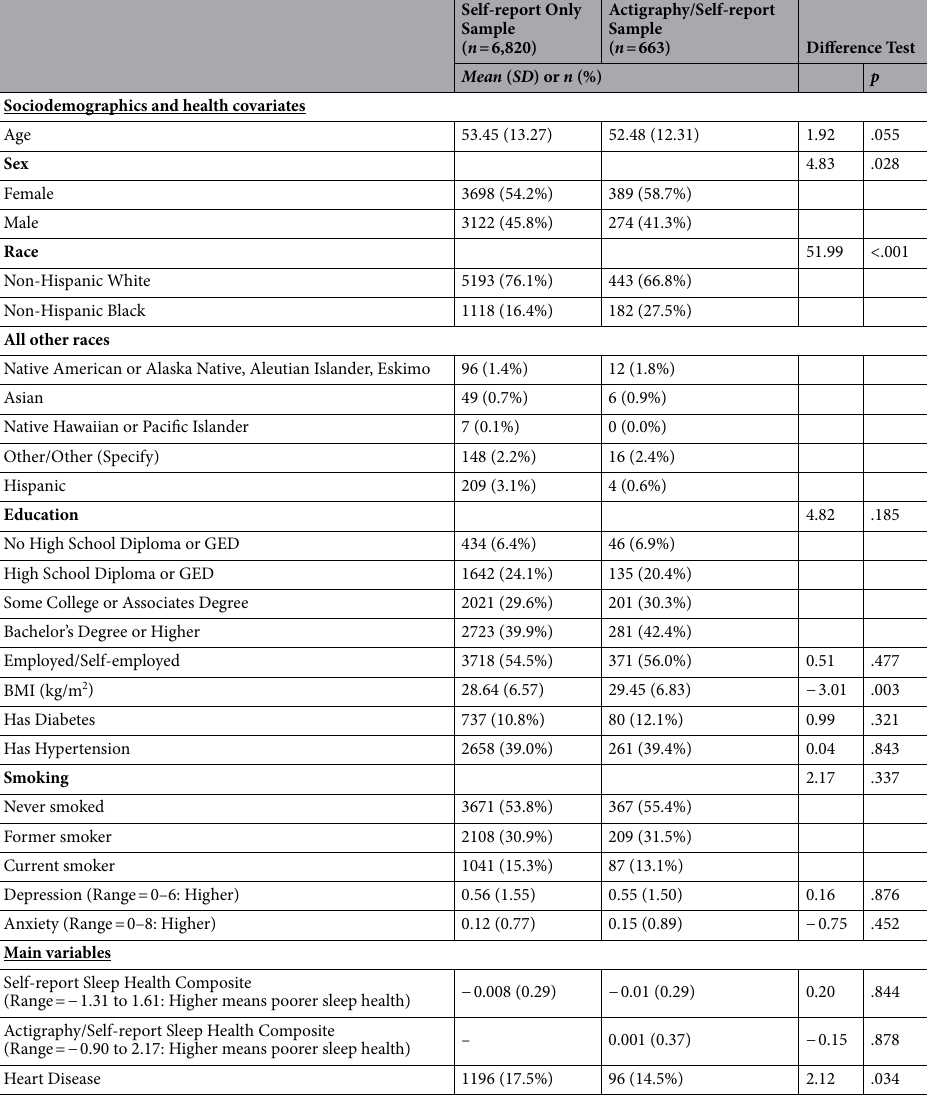
Turning to racial differences, non-Hispanic Black individuals had the highest number of sleep health prob- lems, followed by all other races, and then non-Hispanic White individuals. This was observed in both the self- report and actigraphy/self-report sleep health composites. Race was significantly associated with heart disease, only in the actigraphy/self-report sample. Non-Hispanic Black individuals had the highest prevalence, followed by non-Hispanic White individuals, and other races. There was one significant moderation by race in the associa- tion between the actigraphy/self-report sleep health composite and heart disease. Compared to non-Hispanic White individuals, those with all other races exhibited a weaker association between the actigraphy-self-report sleep health composite and the risk of heart disease ( B = − 5.83, SE = 1.77, 95% CI [− 9.30, − 2.37], P = .001). See Fig. 4 for the nature of this interaction and slope estimates. For non-Hispanic Whites, more sleep health problems were associated with significantly higher risk of heart disease. This was similar for non-Hispanic Blacks with no difference to non-Hispanic Whites ( B = − 0.60, SE = 0.42, 95% CI [− 1.42, 0.22], P = .151). However, for those with other races, the slope was not significant. Race did not moderate the association between the self-report sleep health composite and the risk of heart disease. See Supplementary Table S1 for results from models stratified by sex or by race. Effect sizes of sleep health composites seemed to vary by groups. Supplemental analyses. All results were consistent with or without history of stroke in the heart disease outcome (results not shown, but available upon request). We also compared the effect sizes of individual sleep